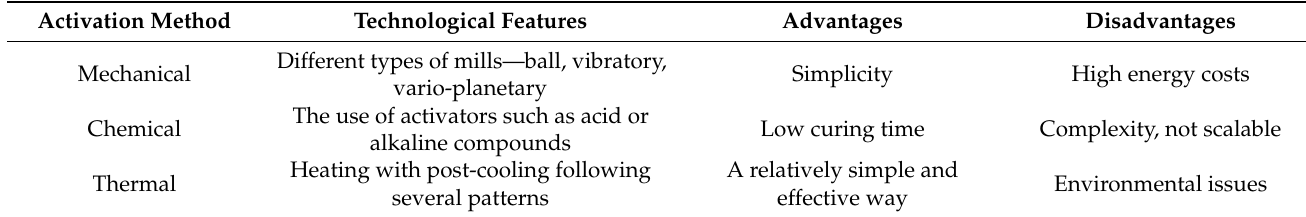
Table 2. Features of the existing activation